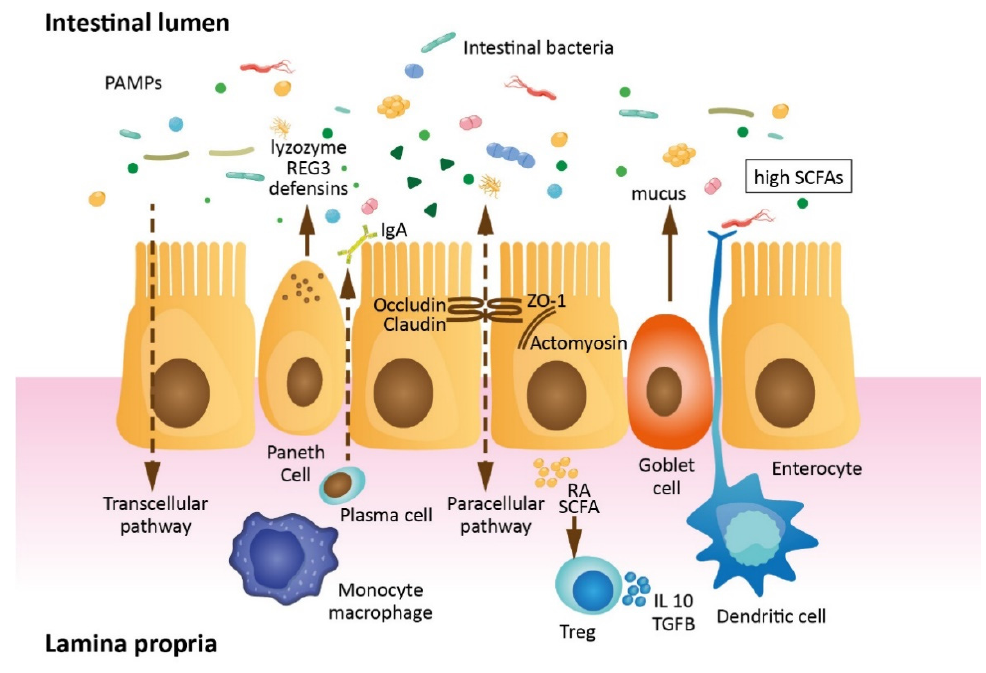
Figure 1. Intestinal barrier. Apically placed tight junctions formed by transmembrane proteins (e.g., claudins and occludin) and peripheral scaffolding proteins (e.g., zonula occludens; ZO-1) seal the paracellular space between enterocytes and form the barrier limiting the intestinal microorganisms and pathogenic molecules (PAMPs) passage and, on the other hand, enabling the paracellular absorption of the essential nutrients and ions, depending on the size and charge. The lamina propria is inhabited by the cells of the immune system, e.g., T cells, plasma cells, macrophages and dendritic cells. Tregs modulate the immune system into a tolerance to self-antigens and chronic stimuli by the secretion of Il-10 and TGF-beta and suppression of effector T cells. The intestinal barrier is maintained by the SCFAs produced by the commensal bacteria and several protective molecules, i.e., lysozyme, defensins, REG3 and IgA, secreted by specialized cells of the intestinal lining. ZO-1, zonula occludens-1, DAMPs, damage-associated molecular patterns, PAMPs, pathogen-associated molecular patterns, IL-10. Interleukin 10, TGF-beta, transforming growth factor-beta, SCFAs, short-chain fatty acids, REG3, regenerating islet-derived protein 3 and IgA, Immunoglobulin A.